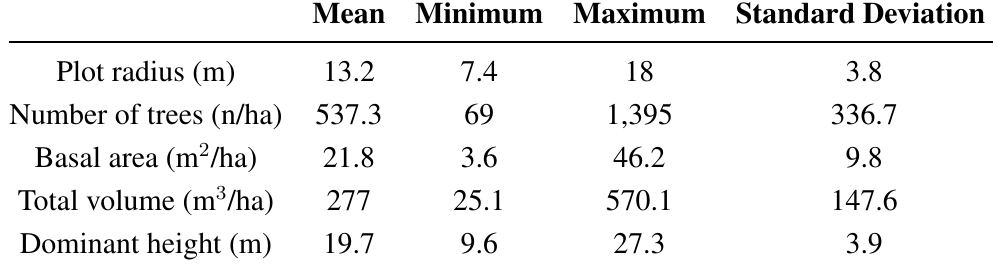
Table 3. Characteristics of deciduous stands. Statistics were obtained from the 36 measured field plots (mean, minimum, maximum and standard deviation